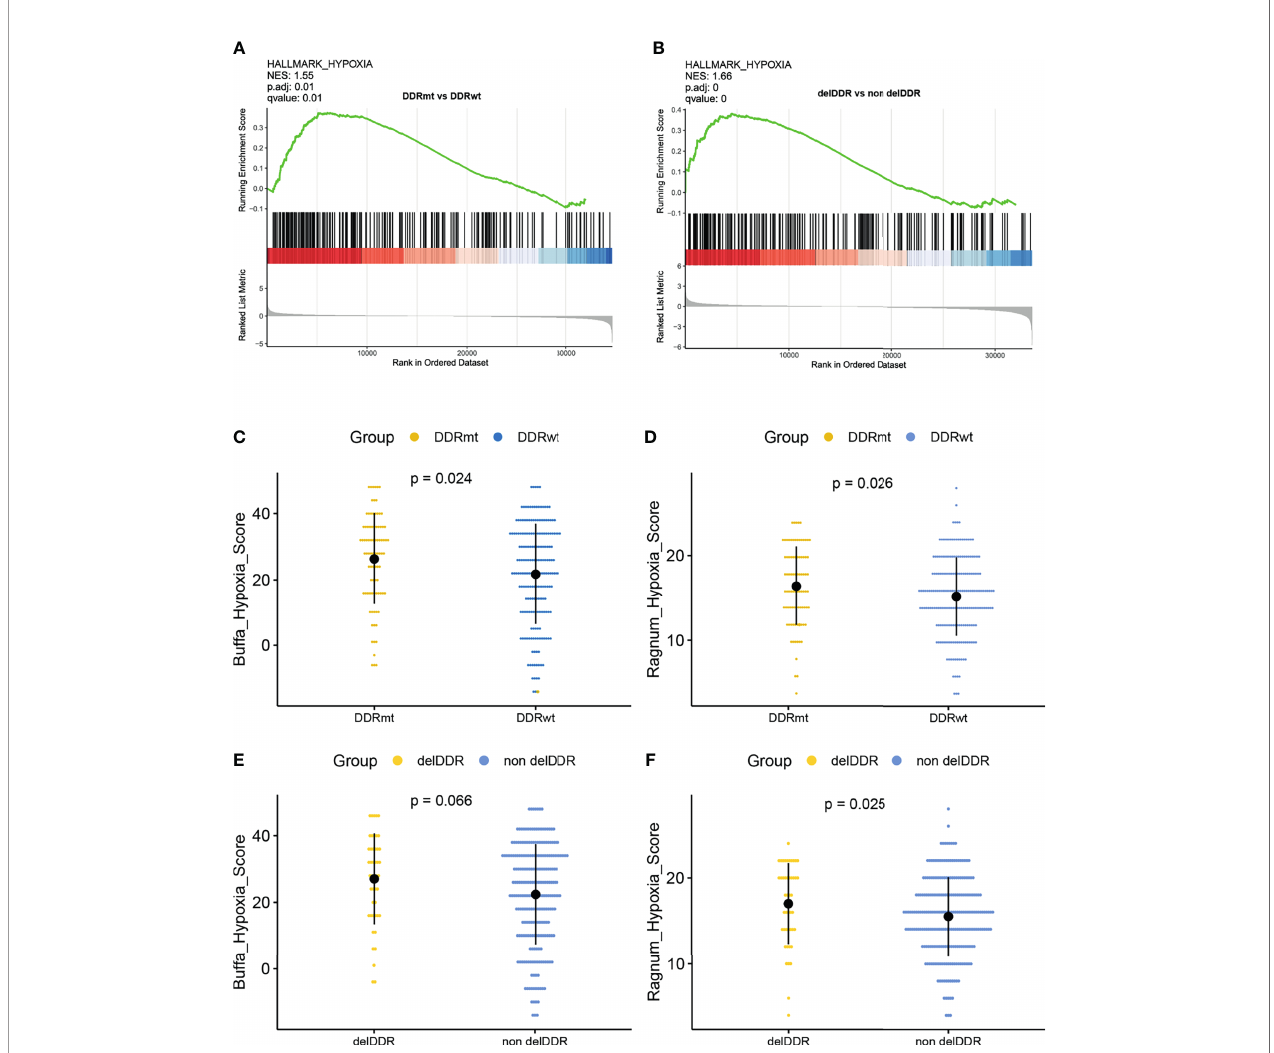
FIGURE 5 | The correlation analyses between the DDR alterations and hypoxia features. (A) Gene set enrichment analysis identi fi ed hallmark_hypoxia in patients with DDR alteration. (B) Gene set enrichment analysis identi fi ed hallmark_hypoxia in patients with deleterious DDR alterations. Comparison of the buffa_hypoxia score (C) and ragnum_hypoxia score (D) between patients with and without any DDR alteration. Comparison of the buffa_hypoxia score (E) and ragnum_hypoxia score (F) between patients with or without deleterious DDR